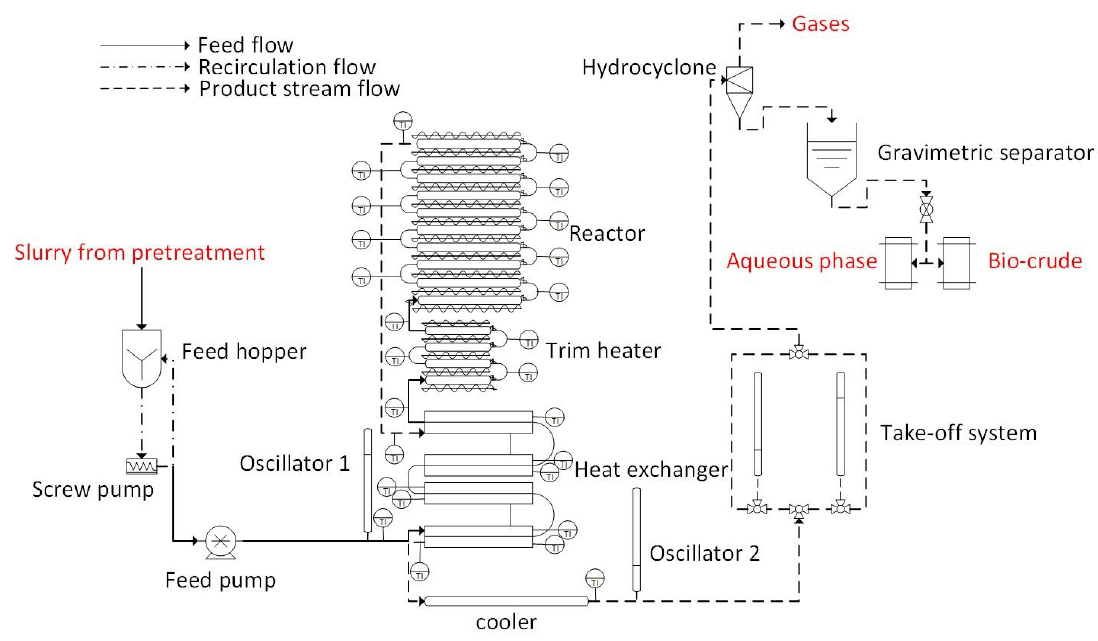
Figure 1. Process flow diagram of the AU pilot-scale HTL reactor.